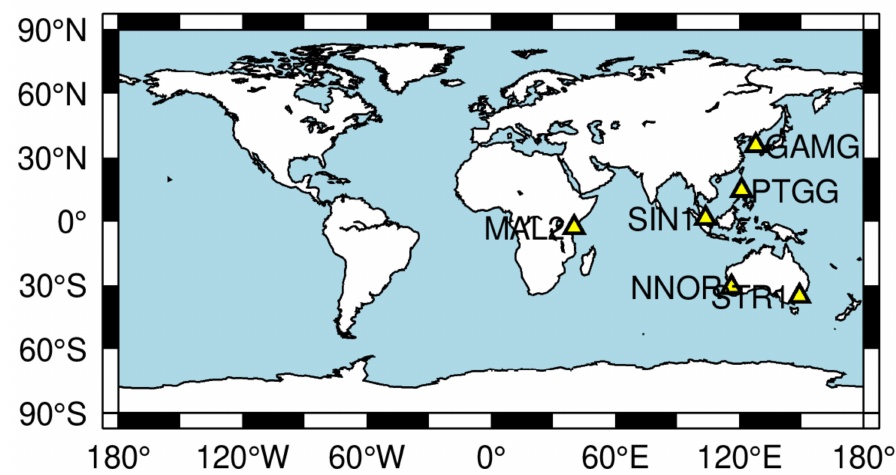
Figure 12. Station distribution for PPP validation.